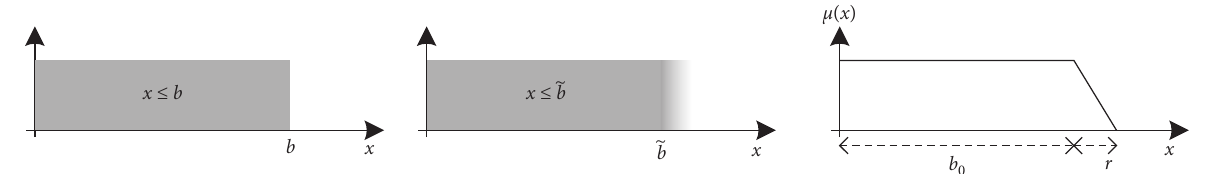
Figure 2: General presentation of (a) crisp inequality, (b) fuzzy inequality, and (c) membership functions of the fuzzy